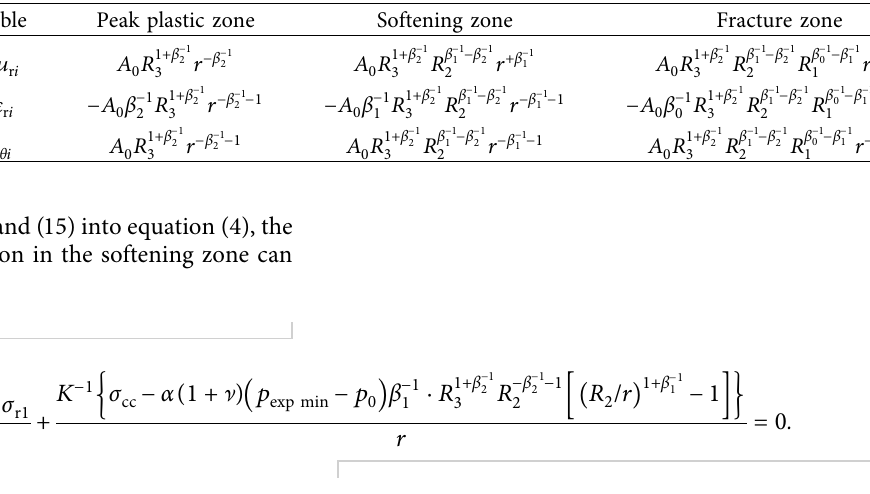
Table 1: Radial displacement and strain of the postpeak failure